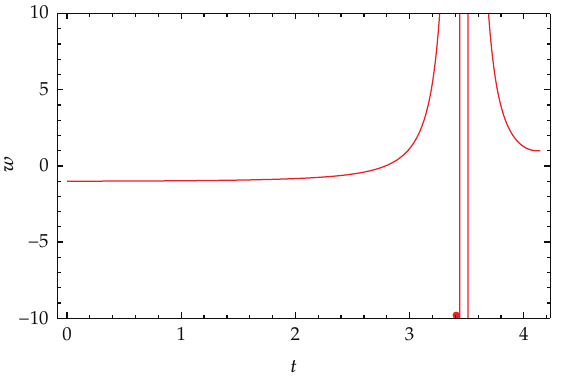
Figure 7: w φ versus t/t 0 . The dot indicates t ∗